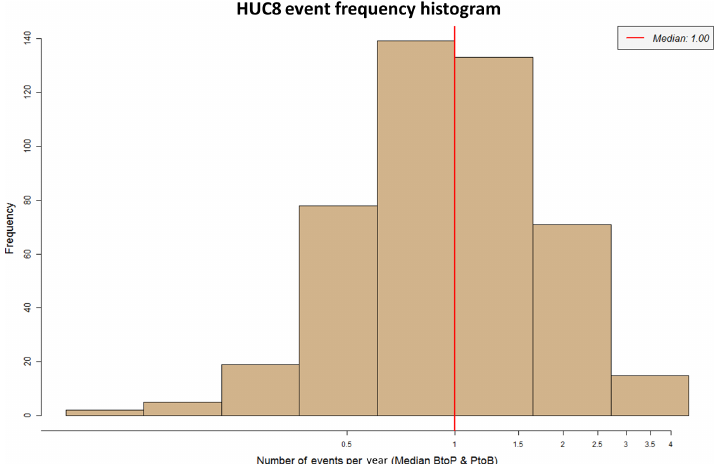
Figure 6. HUC8 frequency